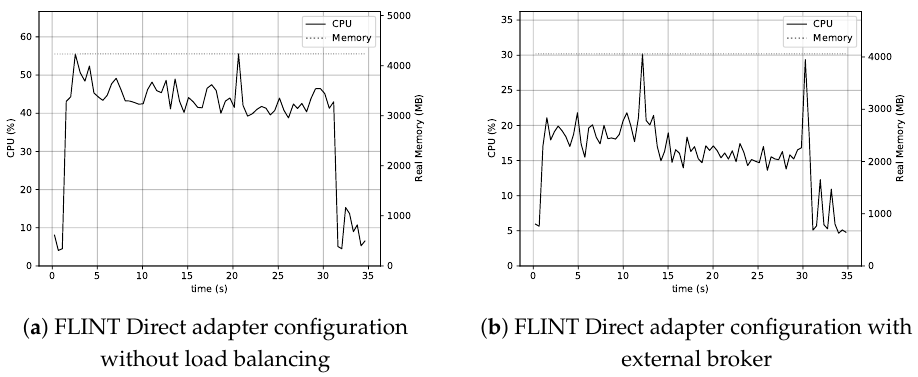
Figure 12. Comparison of a very simple load balancing method. The first configuration runs every component on the same machine, while in the second configuration the broker is moved to a different